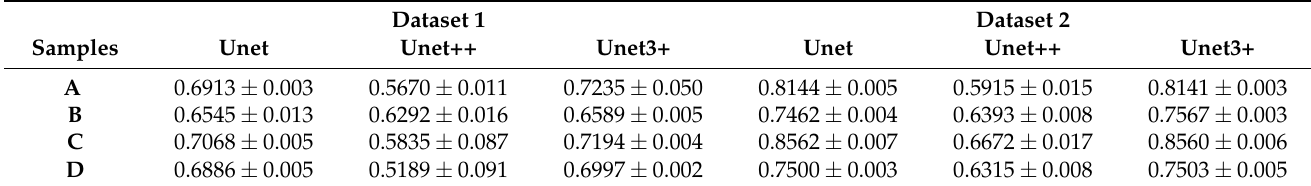
Table 7. Comparison between UNet, UNet++, and UNet3+ in four